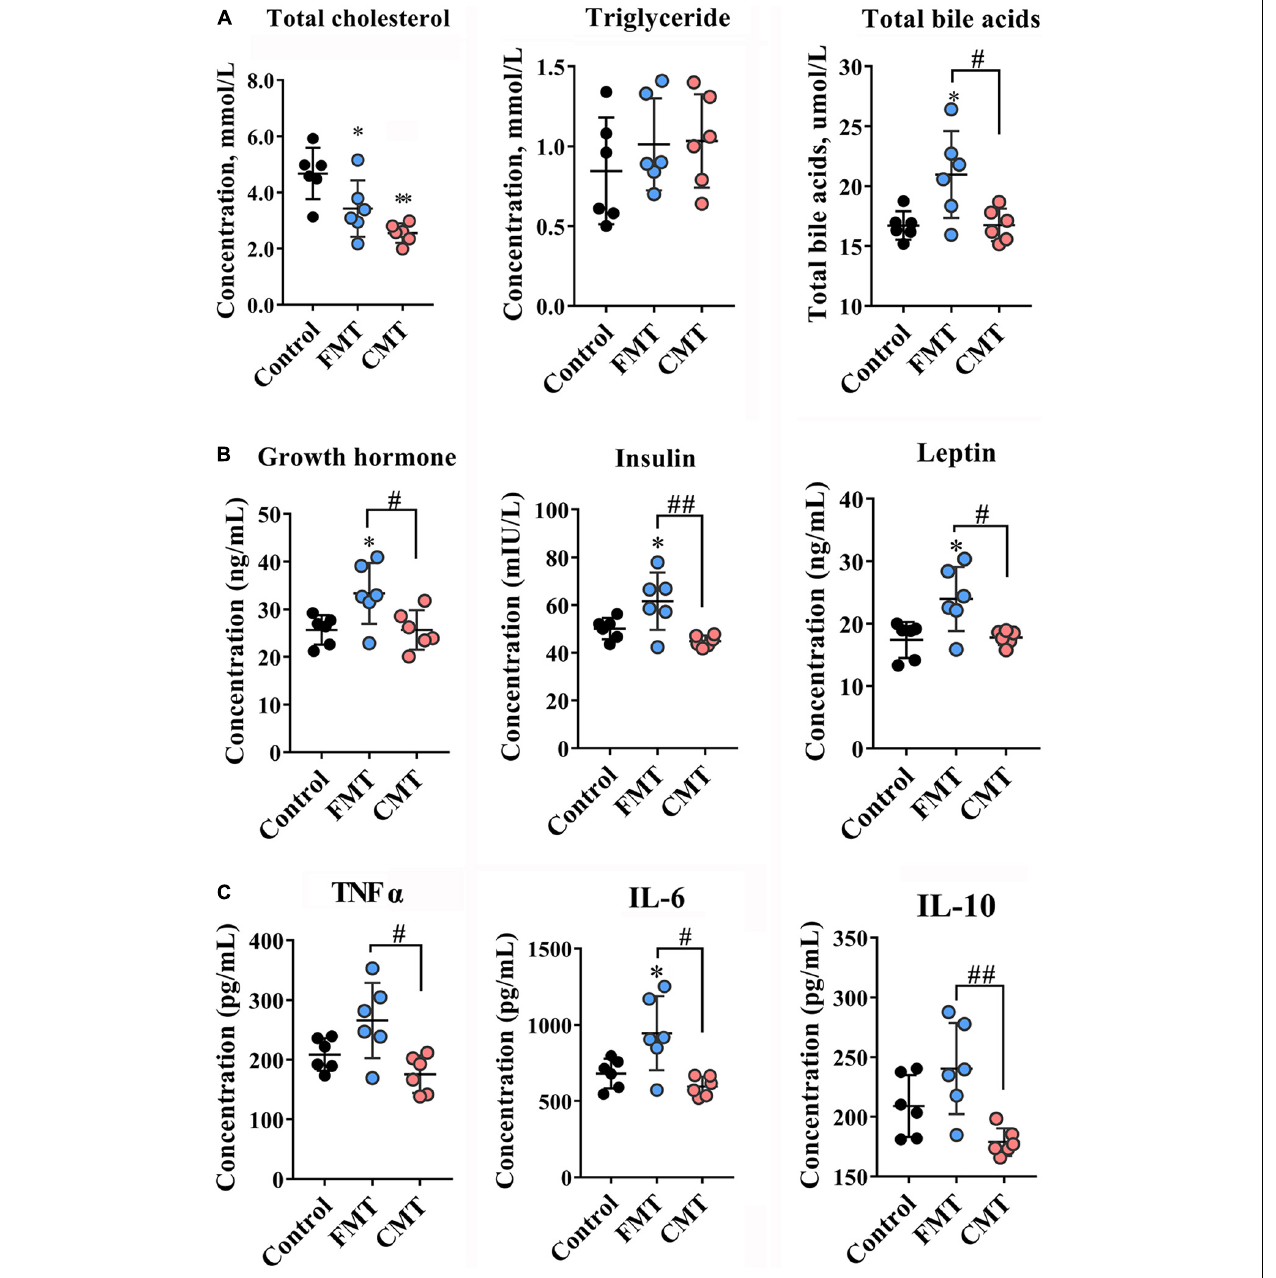
FIGURE 2 | Microbiota transplantation changed blood index of recipient piglets. (A) Lipid contents (total cholesterol, triglycerides, total bile acids) in the blood of piglets ( n = 6). (B) Contents of hormones related to growth (growth hormone, insulin, leptin) in the blood of piglets on day 28 ( n = 6). (C) Inflammatory factors (TNF- α , IL-6, IL-10) in the blood of piglets on day 28 ( n = 6). CMT, colonic microbiota transplantation; FMT, fecal microbiota transplantation. The data are presented as the mean ± SD. ∗∗ Indicates P < 0.01, and ∗ indicates P < 0.05 compared with the control; ## indicates P < 0.01, and # indicates P < 0.05 between the FMT and CMT